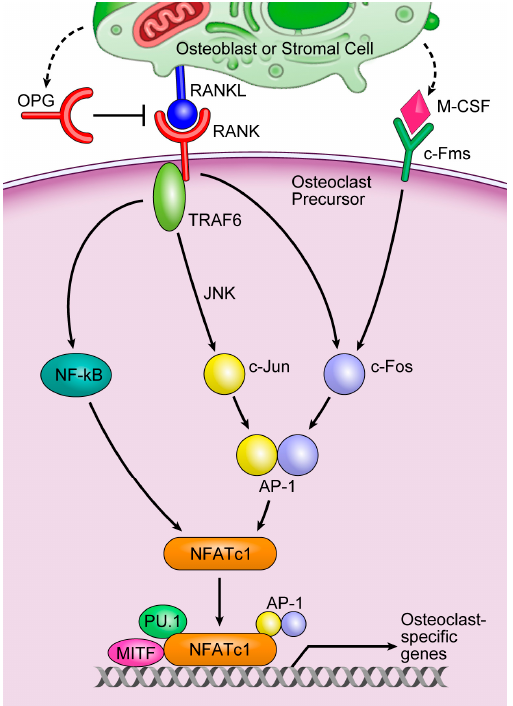
Figure 2. A key osteoclastogenesis signaling cascade. Cited from [2]. The binding of M-CSF to its receptor, c-Fms, induces the transcription factor c-Fos, whereas the binding of RANKL to its receptor, RANK, leads to the recruitment of TNF-receptor-associated factor 6 (TRAF6), the main adapter molecule of RANK. TRAF6 activates nuclear factor κ B (NF- κ B) and mitogen-activated kinases including c-Jun N-terminal kinase (JNK). JNK activates the transcription factor c-Jun. RANKL/RANK also induces c-Fos to form AP-1, a heterodimeric transcription factor, with c-Jun. AP-1 and NF- κ B then induce NFATc1, a master transcription factor that regulates osteoclast differentiation. NFATc1 works with other transcription factors, such as AP-1, PU.1, and microphthalmia-associated transcription factor (MITF) to induce various osteoclast-specific genes.